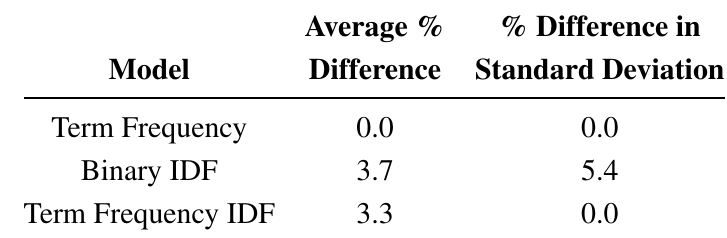
Table 6. Percent difference shown between models with numerical words, and models without numerical words.